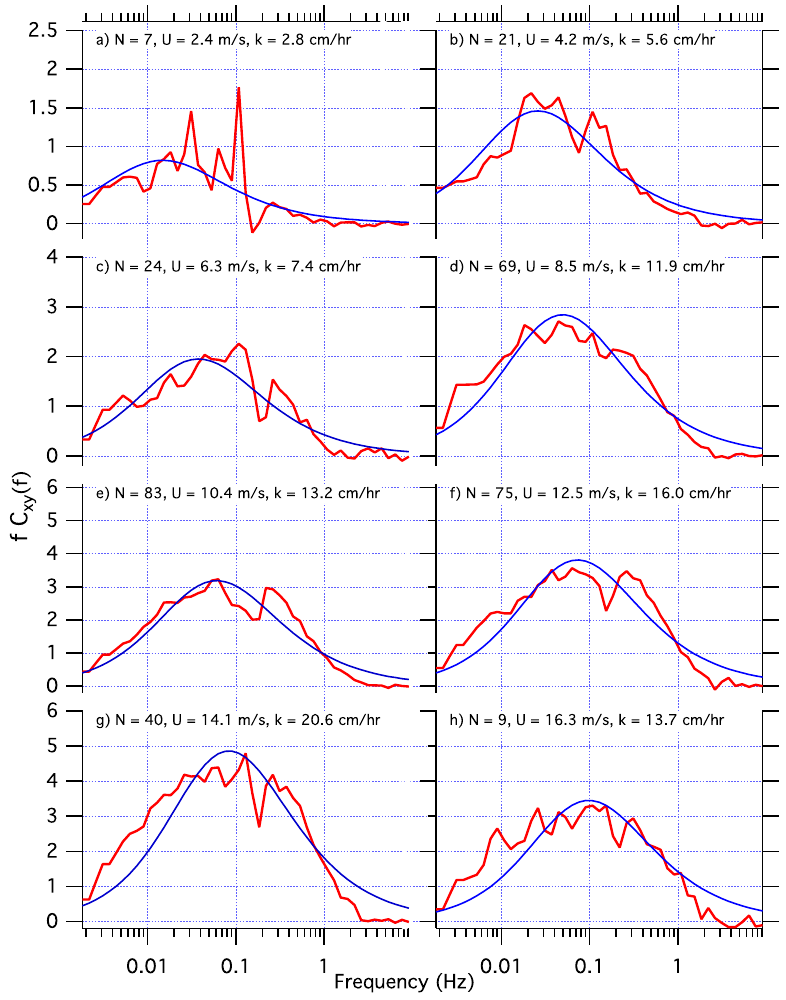
Fig. 6. Mean normalized cospectra, computed from hourly w :dms cospectra normalized to sea water DMS concentration, adjusted to Sc =660 and binned by mean 10m wind speed. For comparison, the blue trace shows the expected theoretical cospectral shape for neutral conditions at the bin-centroid wind speed and z = 18m, scaled to the area of the observed